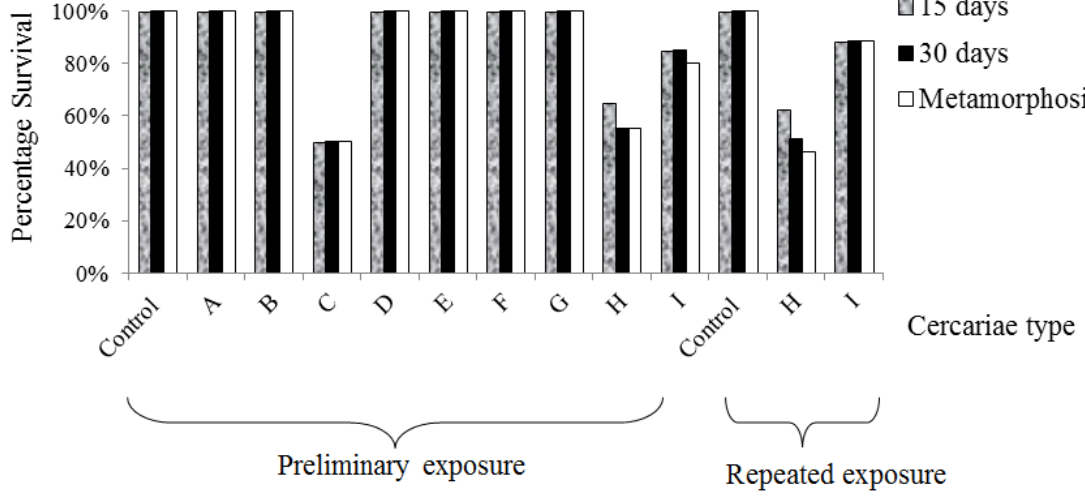
Figure 5: Percentage survival of tadpoles at 15 days post-hatch, 30 days post-hatch and at metamorphosis in the preliminary exposures to nine types of cercariae (A-I). Note: The percentages were taken by dividing the number of survived individuals (at a particular day) by the initial number of